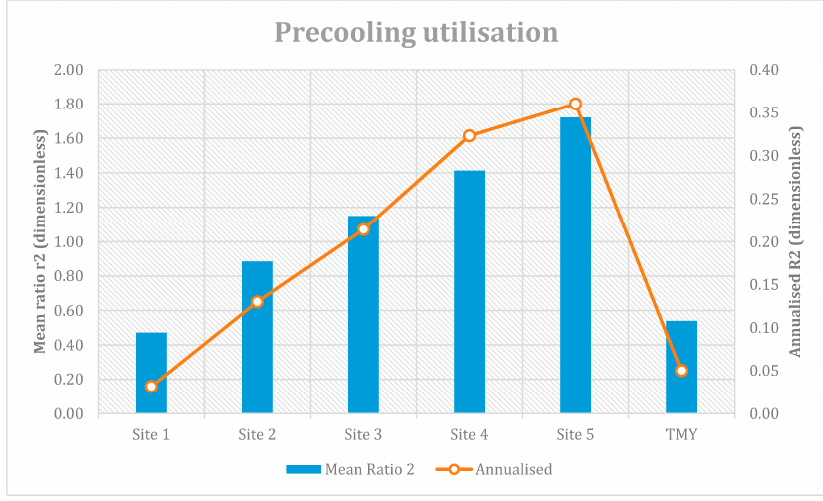
Figure 7. Precooling utilisation summary for sites across Sydney.